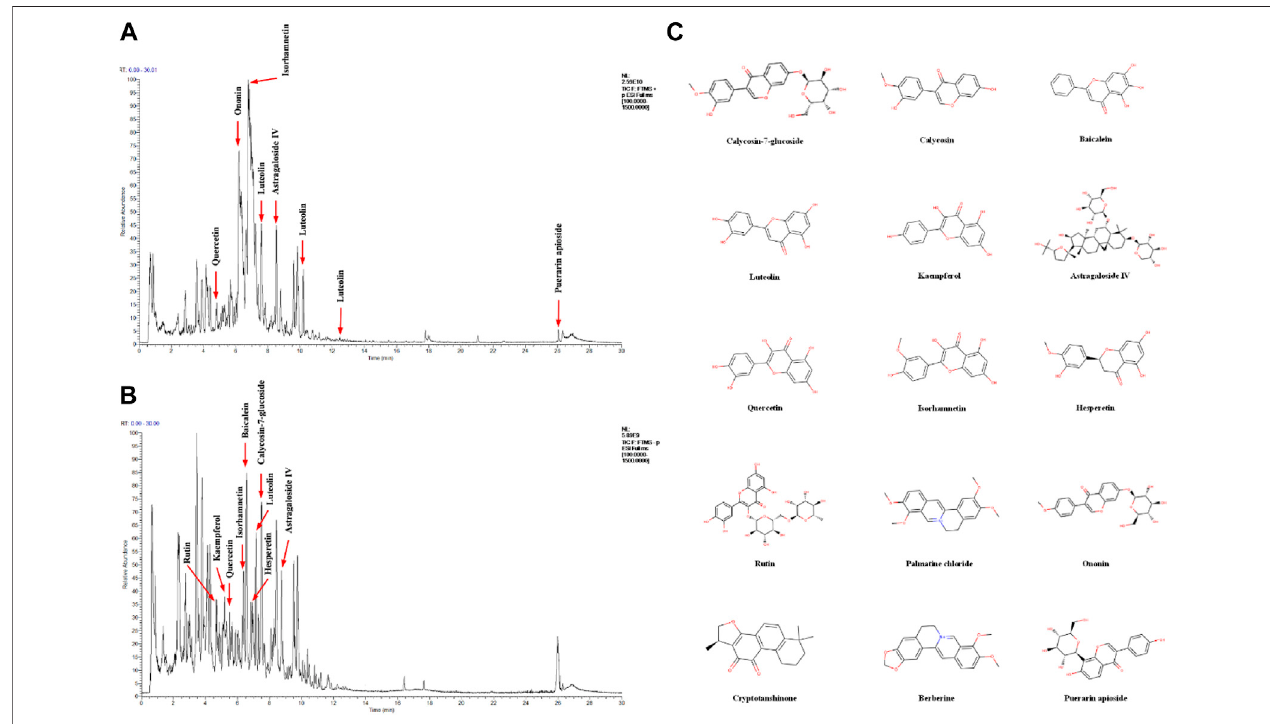
FIGURE 1 | Identi fi cation of chemical components of Yiqi Jiedu Huayu decoction (YJHD). YJHD samples were examined by UHPLC – MS/MS. Total ion chromatography in positive (A) and negative (B) ion modes for YJHD samples are shown. (C) Molecular structure of constituents. UHPLC – MS/MS, ultra-high performance liquid chromatography tandem mass